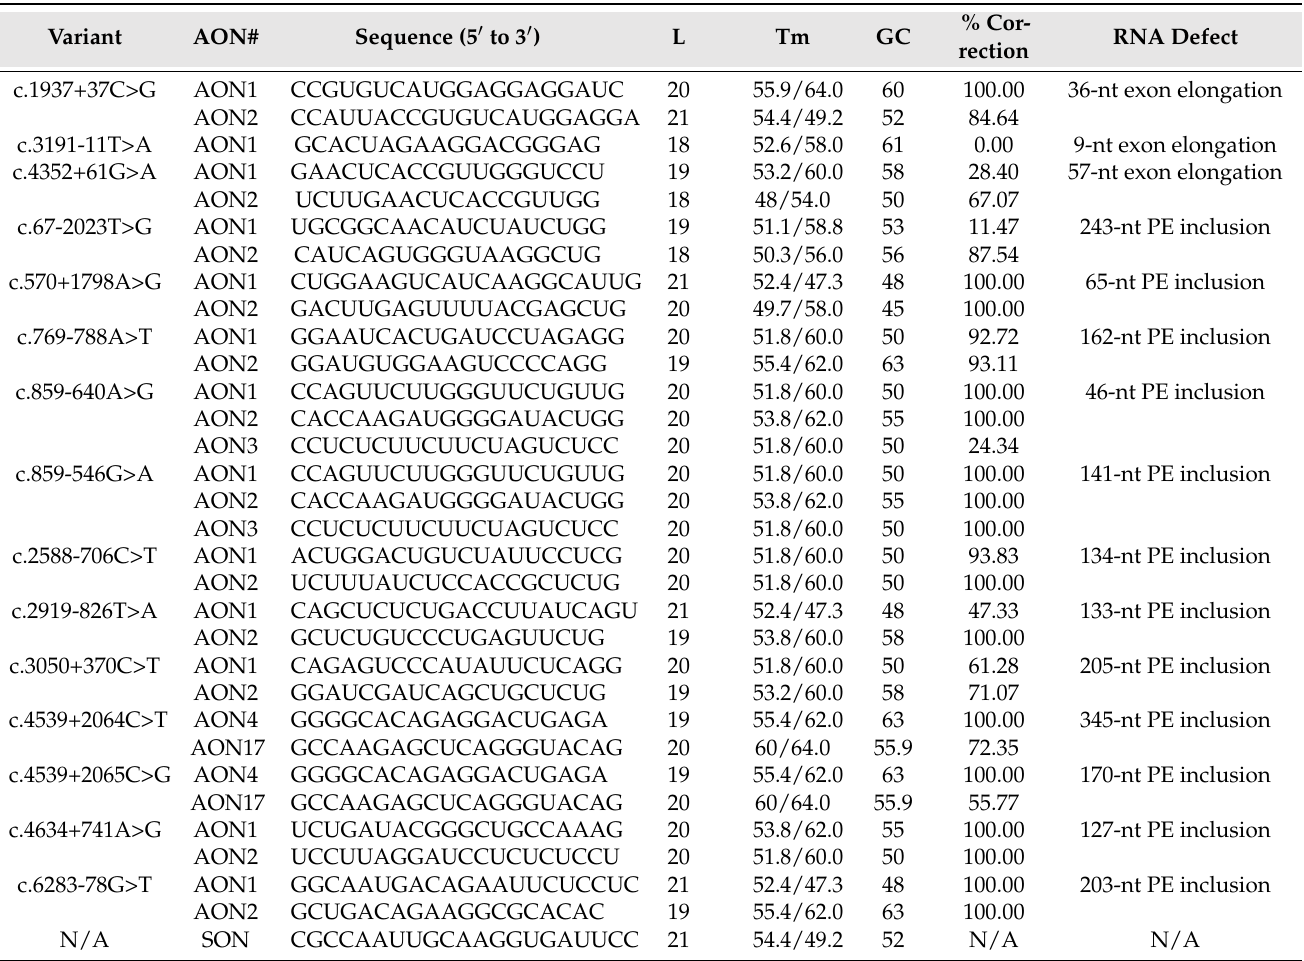
Table 1. Antisense oligonucleotide (AON) sequences and characteristics for the 15 intronic ABCA4 variants with the corresponding RNA